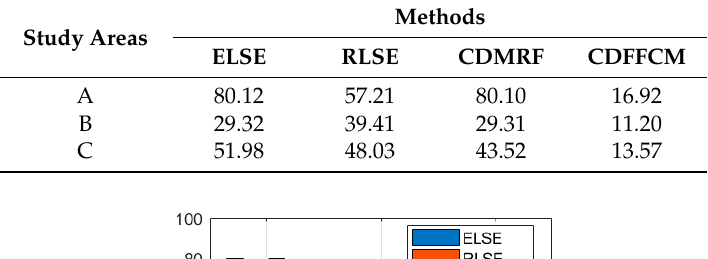
Table 6. Comparison of execution time of four different approaches (in seconds).